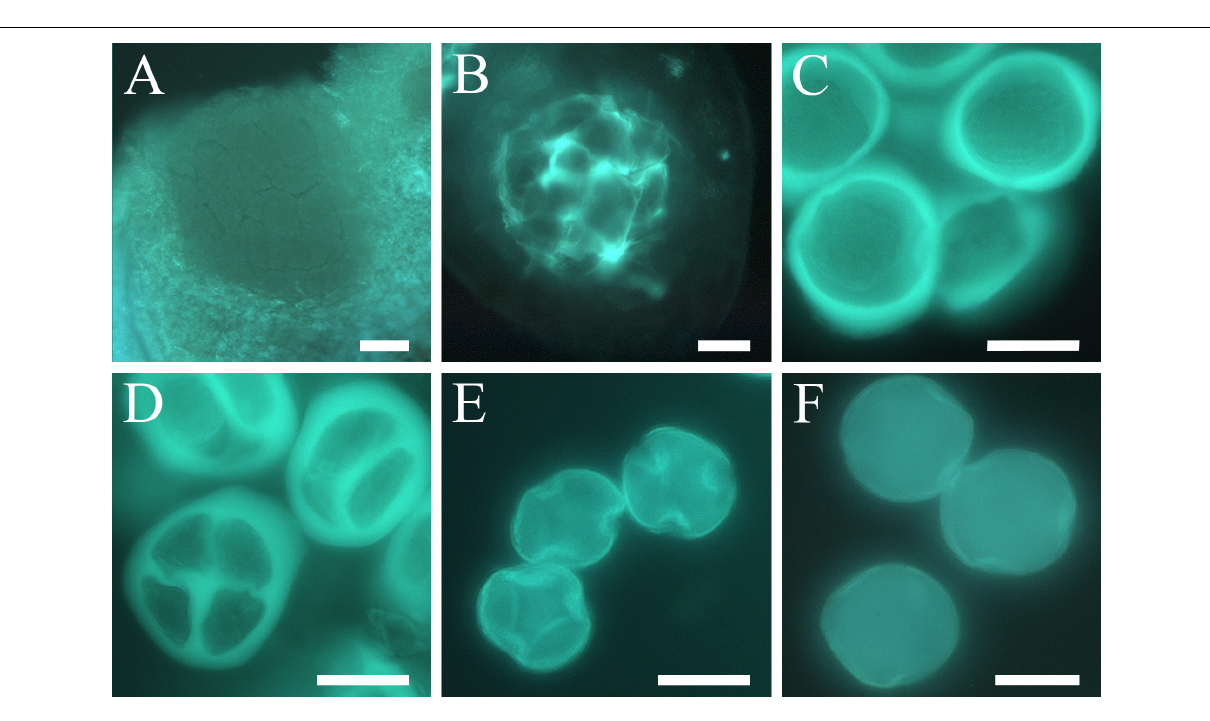
FIGURE 5 | Anther development and microsporogenesis in apricot. (A) Sporogenous tissue. (B) Appearance of callose indicating the onset of microspore mother cell differentiation. (C) Early-stage microspore mother cells surrounded by callose layering. (D) Tetrads. (E) Microspores released. (F) Mature pollen grain. Scale bars: 20 µ